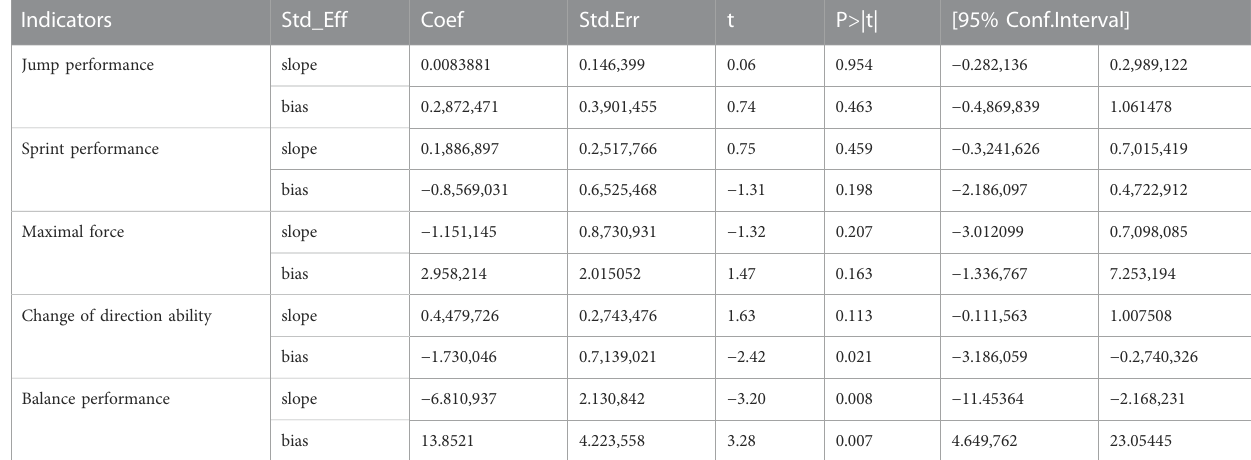
TABLE 6 Egger ’ s test results.